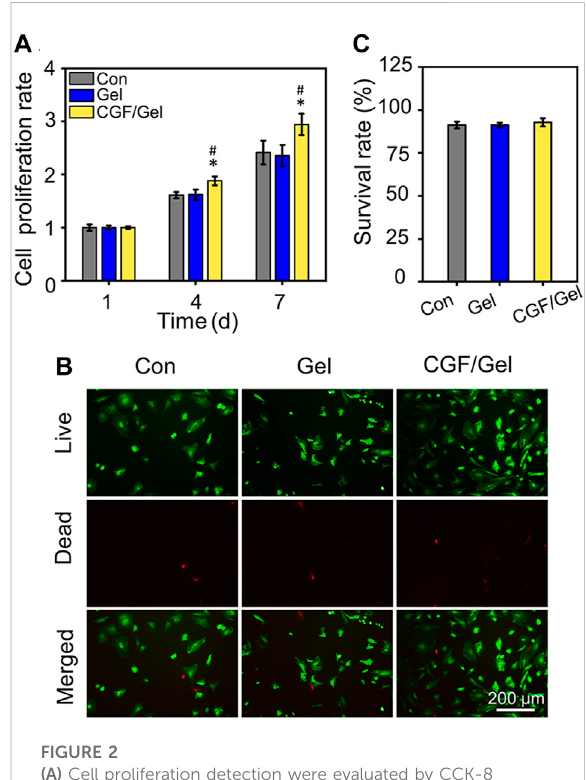
FIGURE 2 (A) Cell proliferation detection were evaluated by CCK-8 assay( n =3). (B) CalceinAM/PIstainingwasconductedtomarkthe living and dead cells. (C) Quantitative analysis of the cell survival ratesoftheCongroup,Gelgroup,andCGF/Gelgroup,which are 91.21% ± 1.95%, 91.22% ± 1.35%, and 92.77% ± 2.43%, respectively ( n = 3) (* p < 0.05 compared with Con group; # p < 0.05 compared with Gel